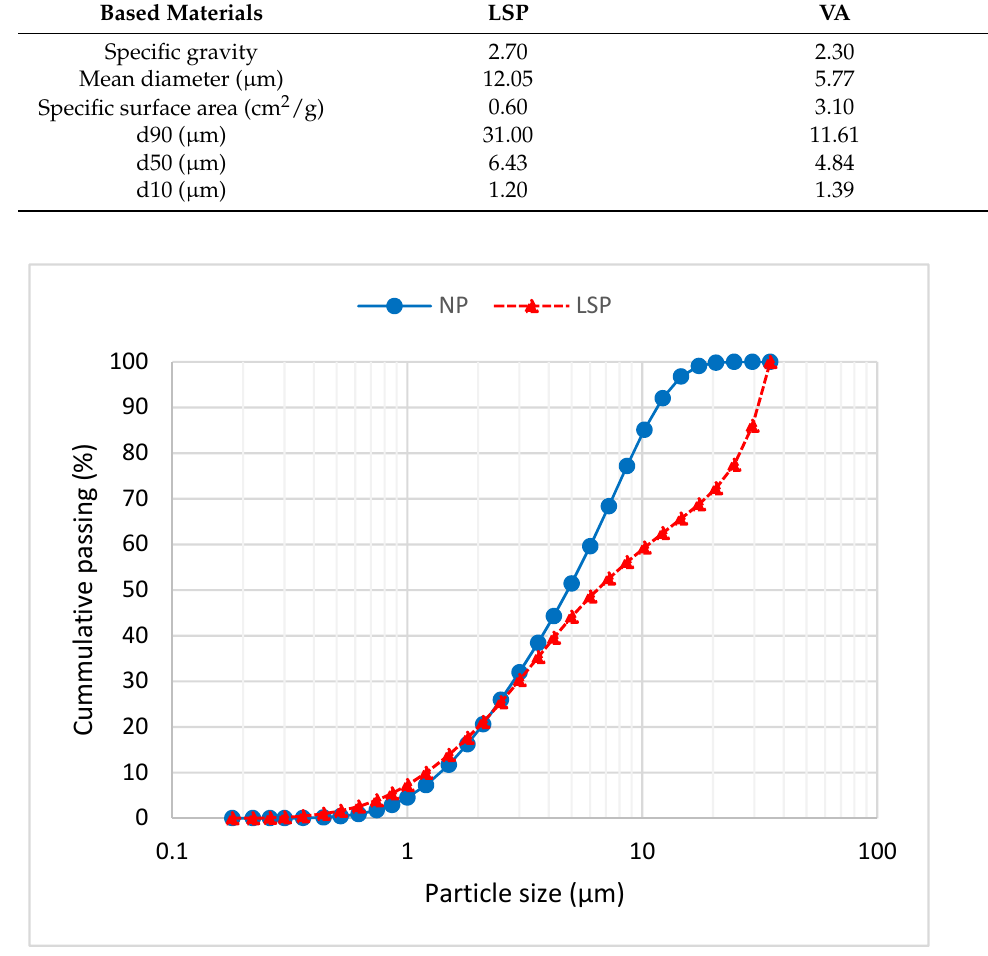
Figure 1. Particle size distribution curve of LSP and VA.